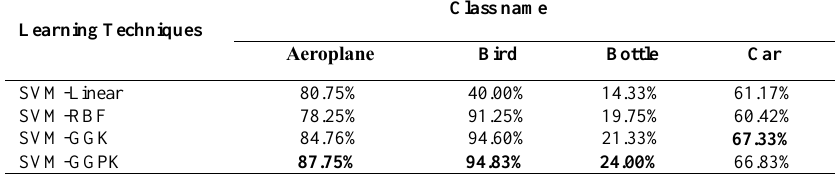
Table 7. Accuracy of SVM with linear, RBF, GGK, and GGPK kernels trained on PASCALVOC2012 dataset.